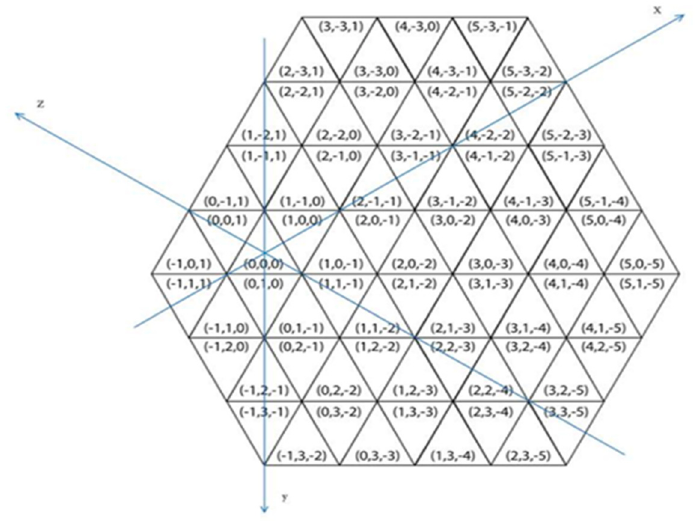
Figure 1. Coordinate system for the triangular grid with the Origin and the axes.